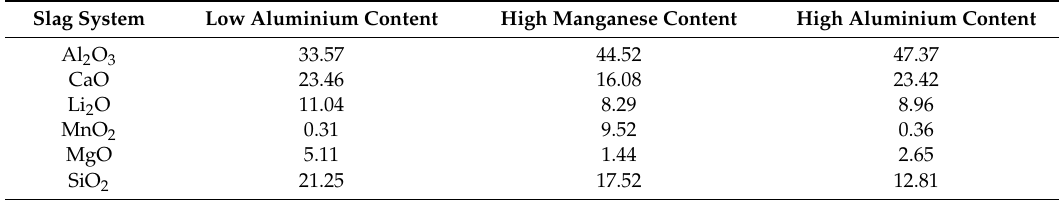
Table 7. Composition of lithium-containing slags from Umicore in wt.%